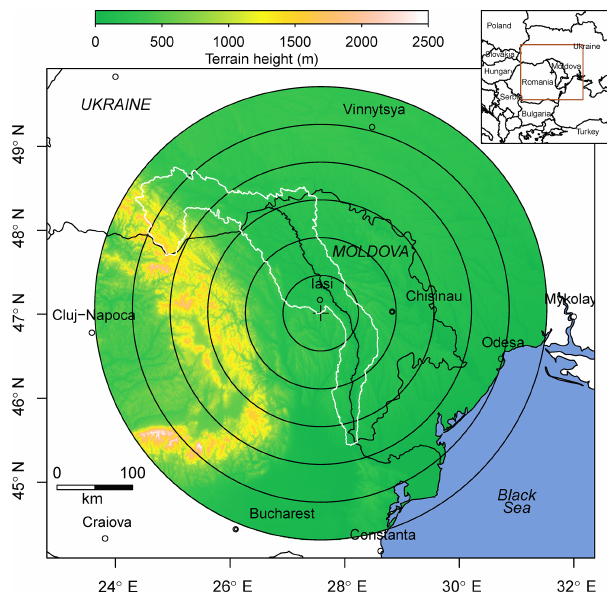
Figure 1. Map of the study area, showing the Prut River basin (white polygon), Bârnova WSR-98D radar location (“ + ” sign), orography, and borders. The range rings around the radar are 50km apart, extending to